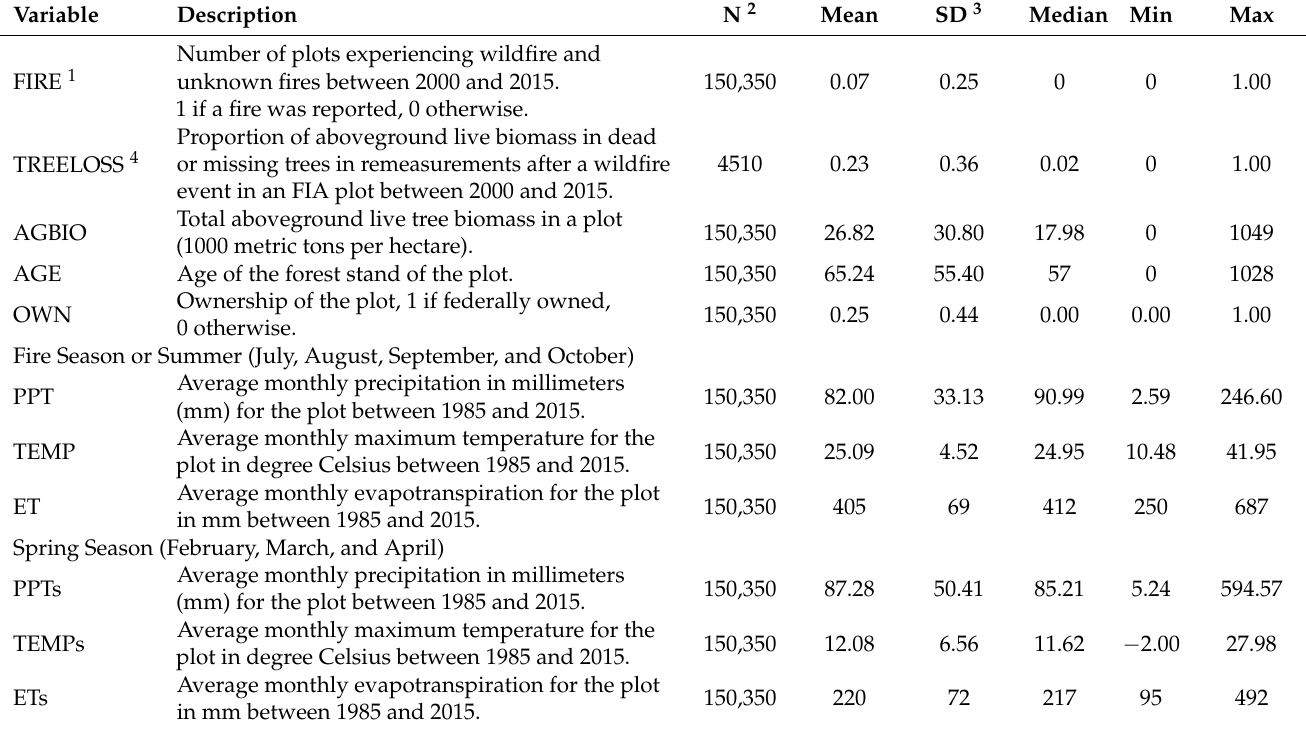
Table 1. Description and descriptive statistics of the climate and forest attributes of FIA forest plots in the continental United